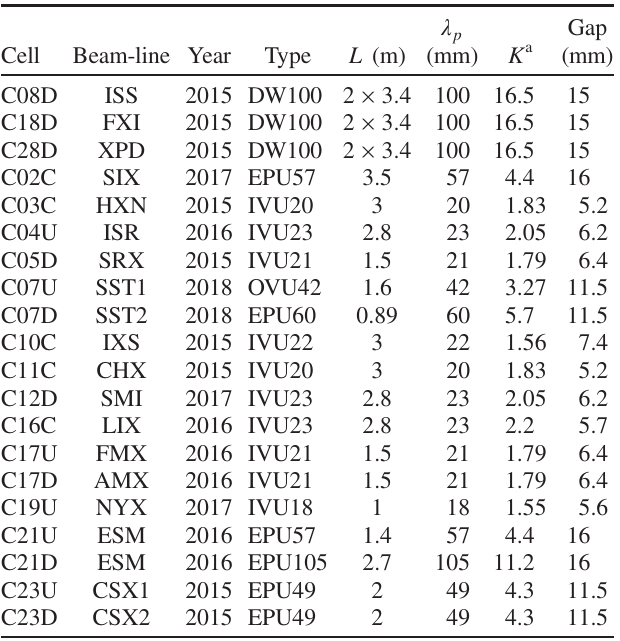
TABLE II. NSLS-II wigglers and undulators. Cell